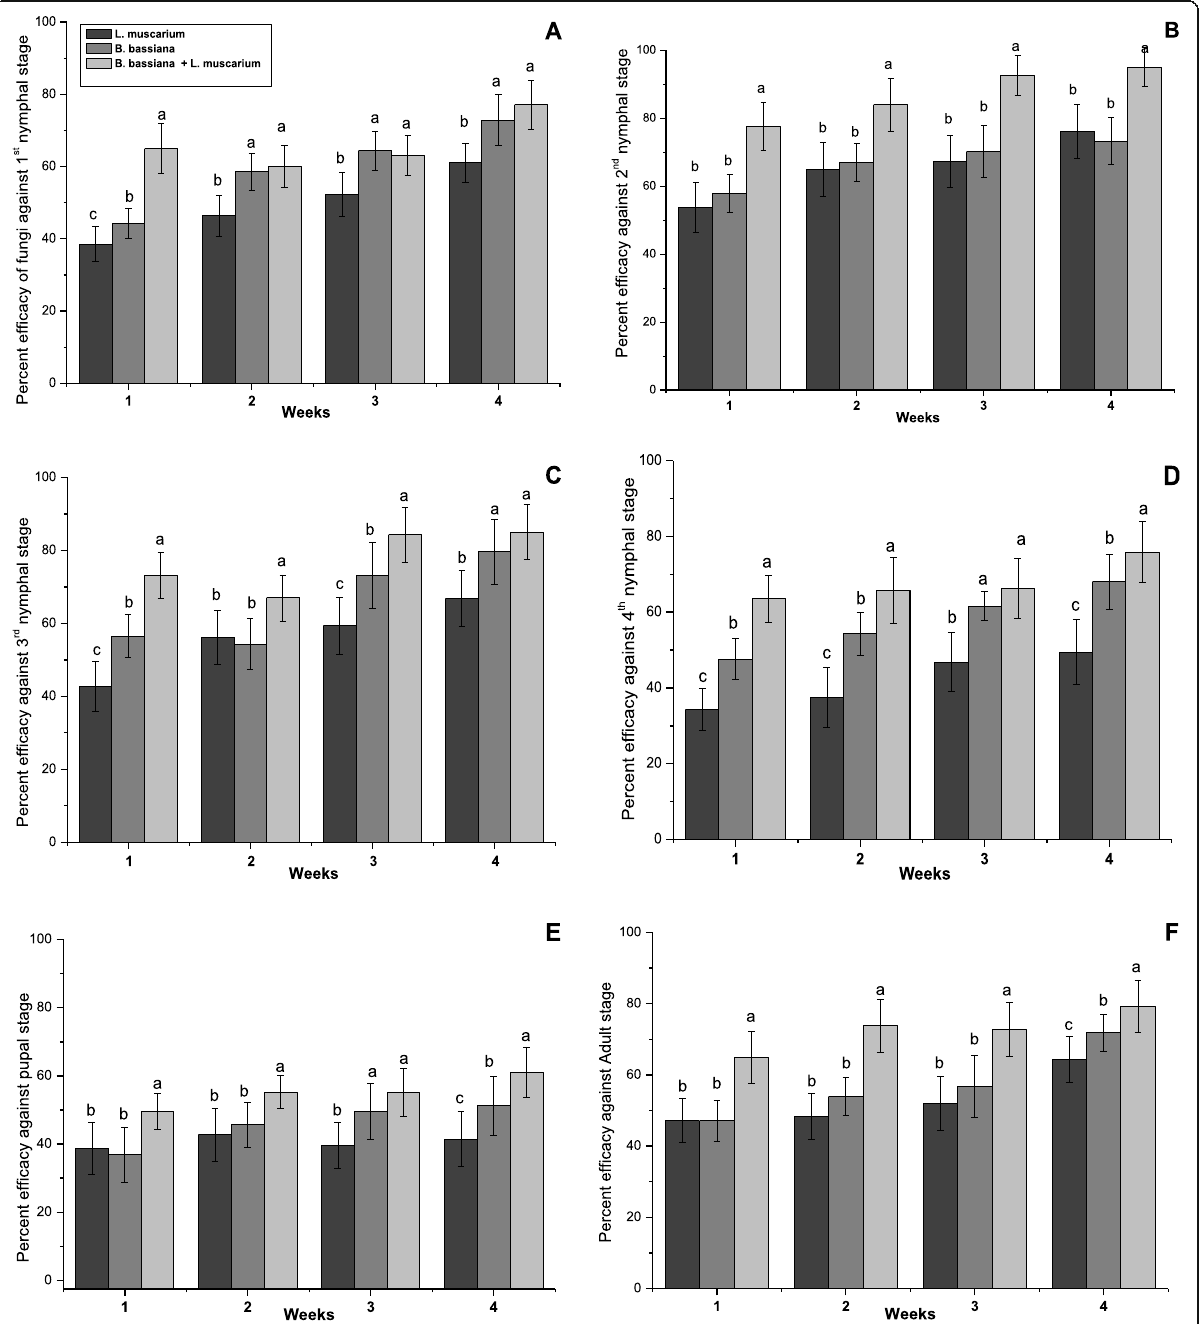
Fig. 3 Mean (±SD) efficacy of entomopathogenic fungi against different stages of development of Bemisia tabaci for 4 weeks. Different letters denote means are significantly different from one another, as determined by Tukey ’ s HSD. a 1st nymphal instar L1; b 2nd instar L2; c 3rd instar L3; d 4th instar L4; e pupa, and f